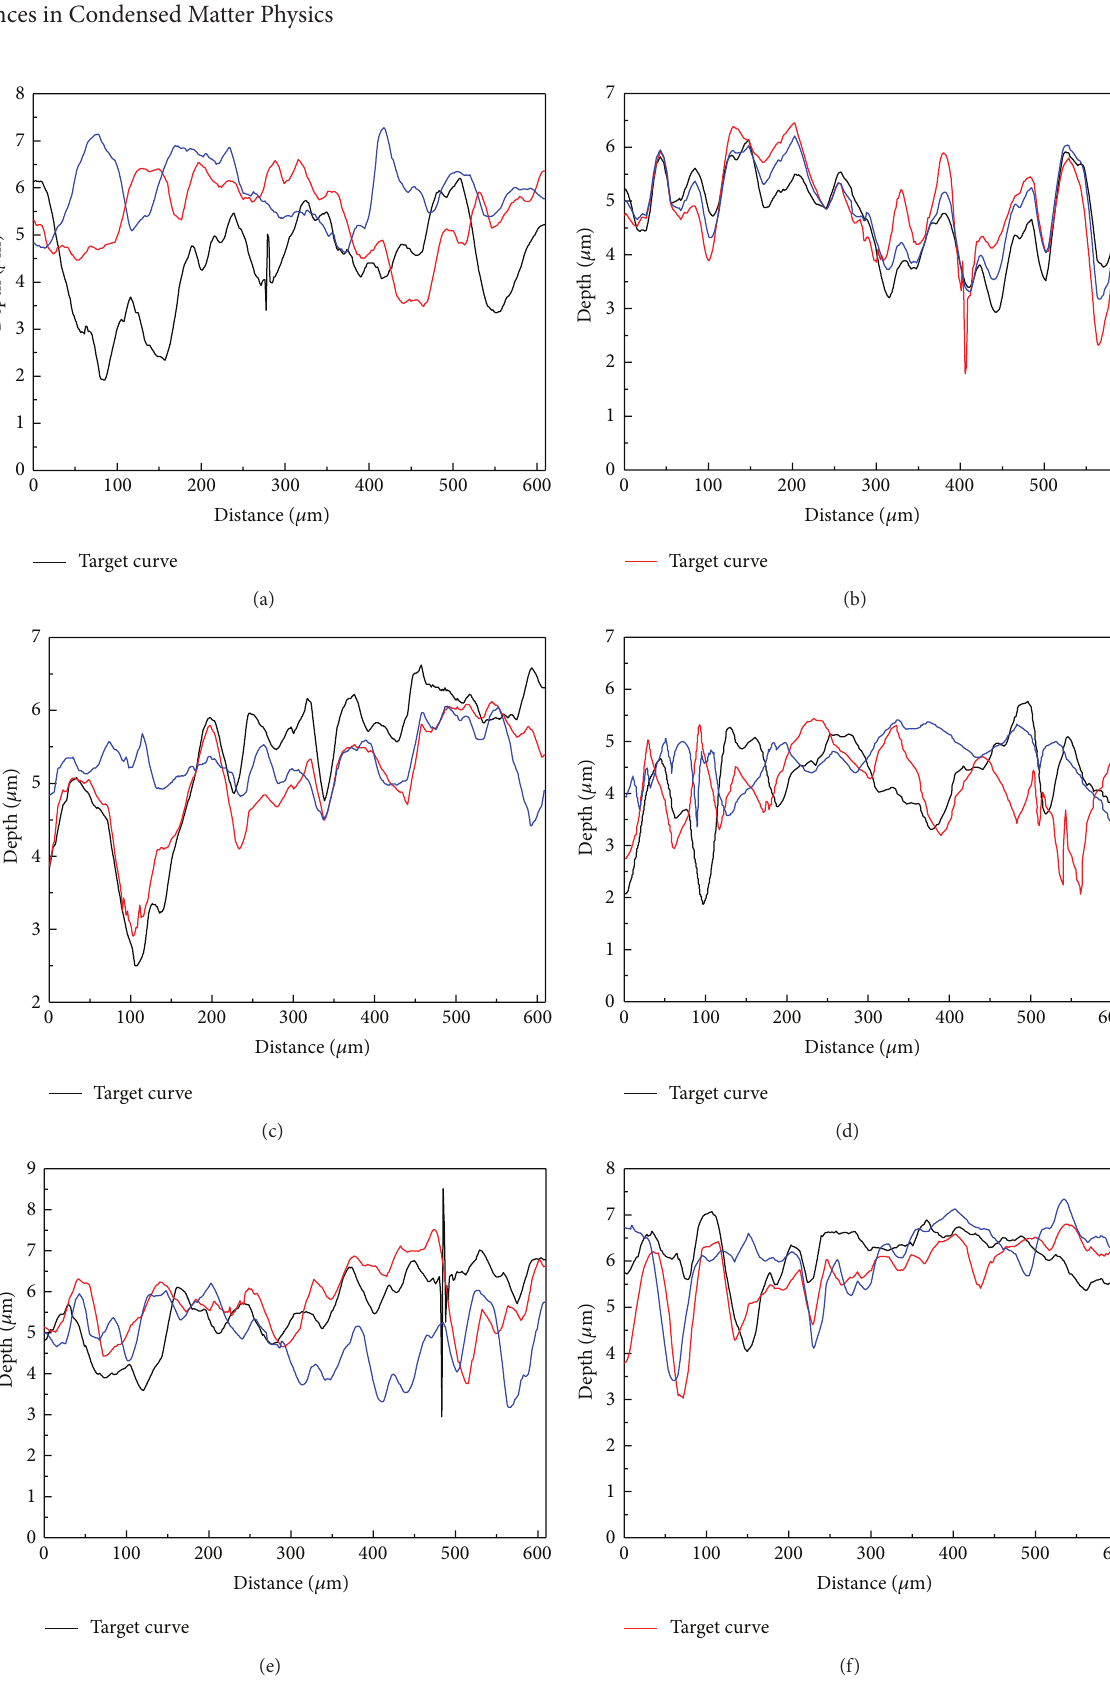
Figure 18: Surface elevation curves of 17-4PH specimens after impact: (a) case 1, (b) case 2, (c) case 3, (d) case 4, (e) case 5, and (f) case